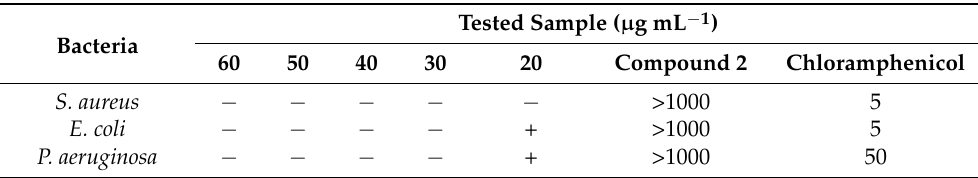
Table 4. MIC of Cobalt(III) pyridoxal-S-methylisothiosemicarbazone complex against tested bacteria for various concentrations, compound 2 , and chloramphenicol.